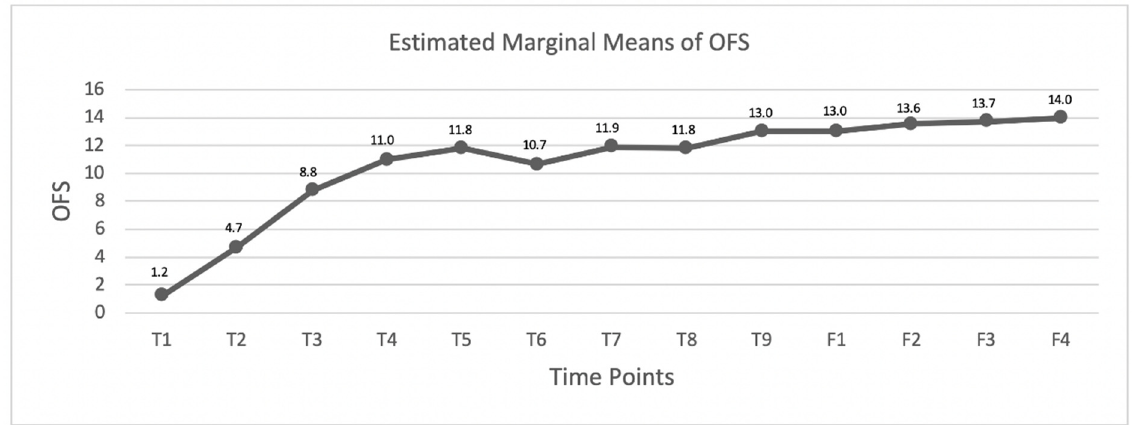
Figure 7. Graphic describing the OFS mean evolution of the DPP + dogs in the study group (SG). T1: admission, T2: day 3, T3: day 7, T4: day 15, T5: day 30, T6: day 45, T7: day 60, T8: day 75, T9: day 90, F1: 8–10 days follow-up, F2: 1-month follow-